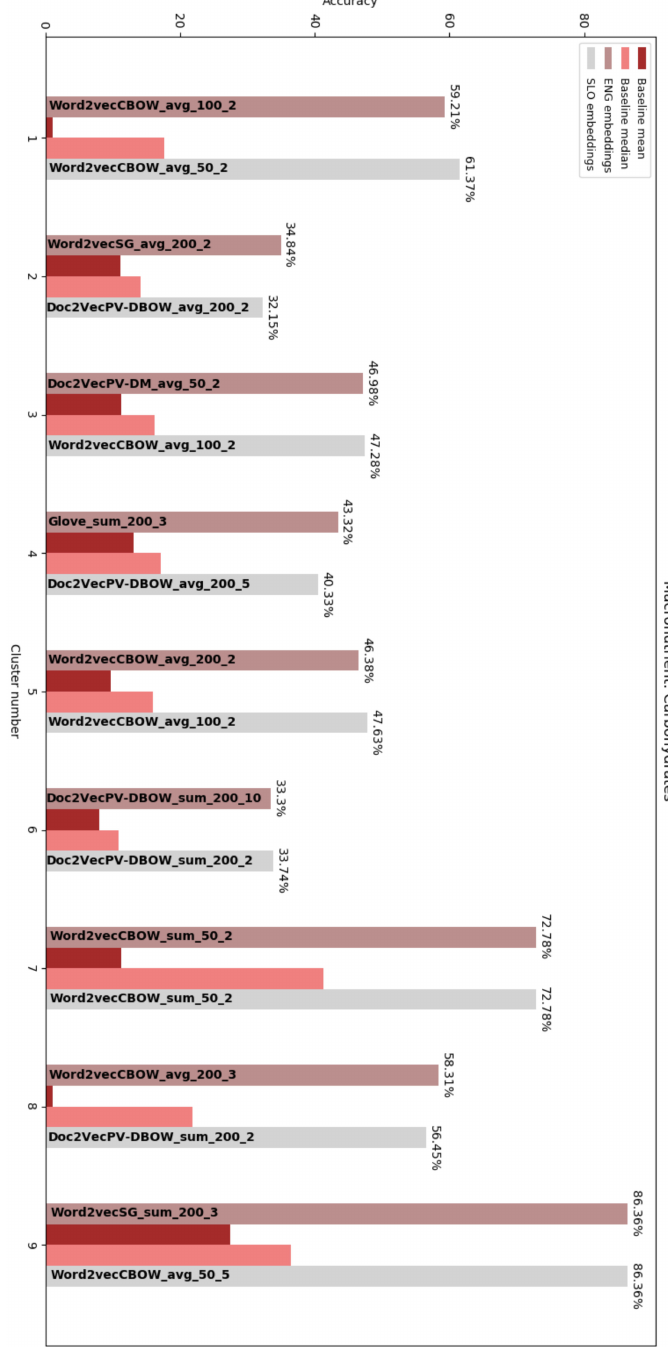
Figure 2. Best prediction accuracies for carbohydrates predictions obtained from the embeddings for the English names and Slovene names for each cluster compared to the baseline mean and median for the particular